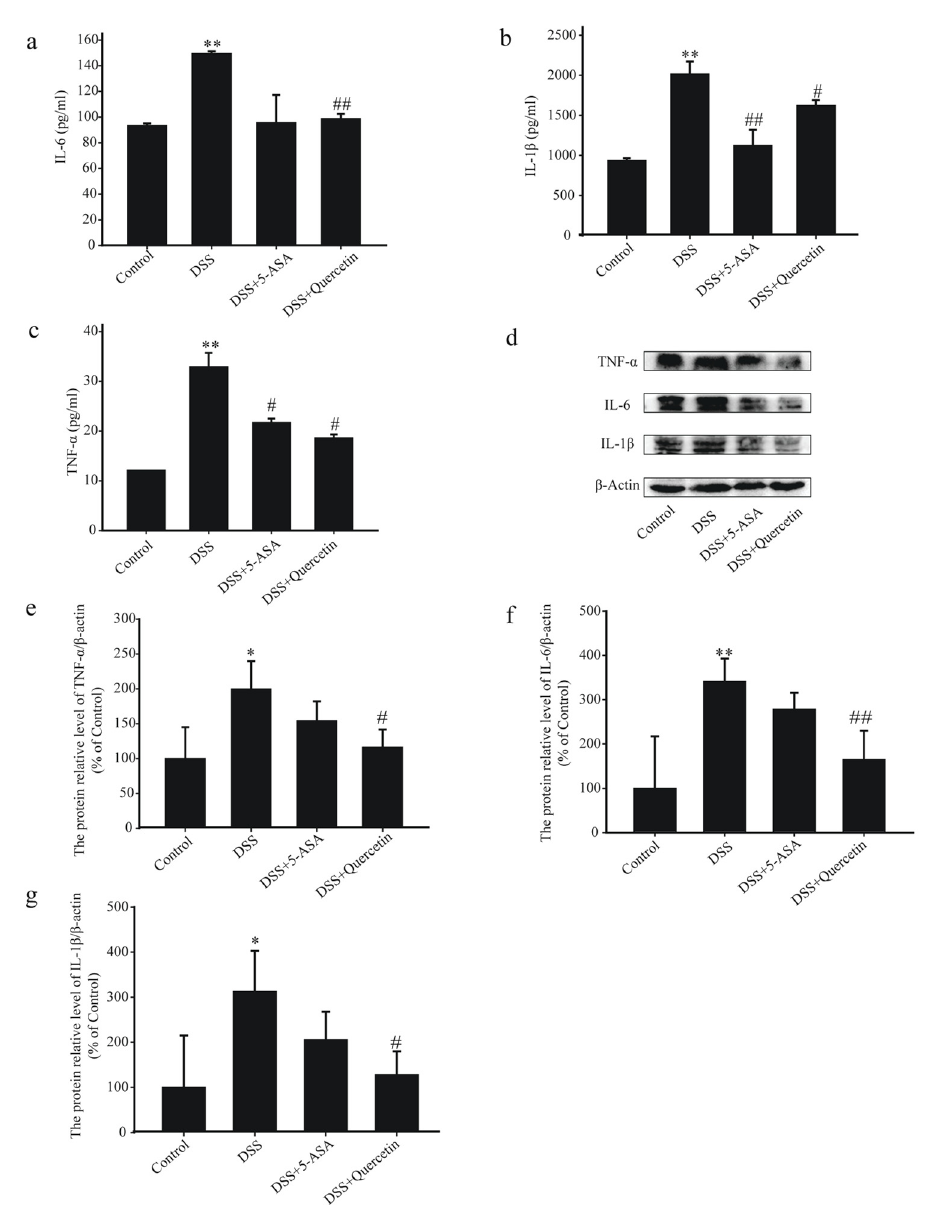
Figure 2. Quercetin reduces levels of inflammatory mediators in the colon of mice with dextran sodium sulfate (DSS)-induced colitis. Enzyme-linked immunosorbent assay analysis of interleukin (IL)-6 ( a ), IL-1 β ( b ), and tumor necrosis factor (TNF)- α ( c ) concentrations in colonic tissue supernatants. ( d – g ) Western blotting analysis of TNF- α , IL-6 and IL-1 β in colonic tissue extracts. * p < 0.05, ** p < 0.01 compared with the control group; # p < 0.05, ## p < 0.01 compared with the DSS group.